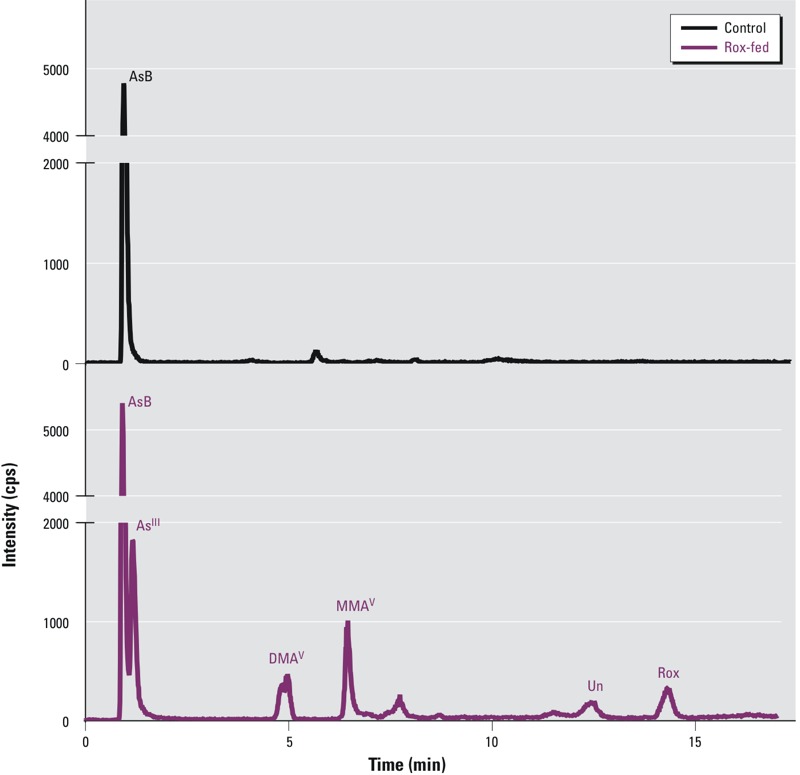
Chromatograms obtained from HPLC-ICPMS analyses of breast samples from a control chicken (top trace) and a Rox-fed chicken (bottom trace) collected on day 28 of the feeding experiment. The control chicken was given a basal diet not containing Roxarsone. The Rox-fed chicken was given a diet containing approximately 18 mg/kg Roxarsone during the first 28 days. Only arsenobetaine (AsB) was consistently present in the control chicken breast samples. AsB, arsenite (AsIII), dimethylarsinic acid (DMAV), monomethylarsonic acid (MMAV), Roxarsone, and an Unknown arsenic species (Un) were detected in the Rox-fed chicken breast samples.